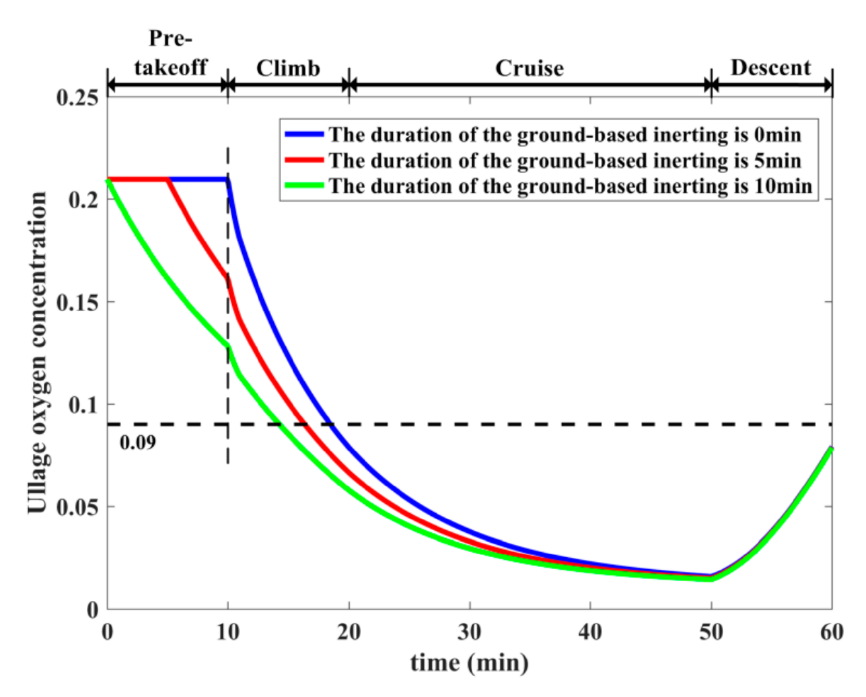
Figure 7. The ullage oxygen concentration regarding the ground-based inerting duration, with .